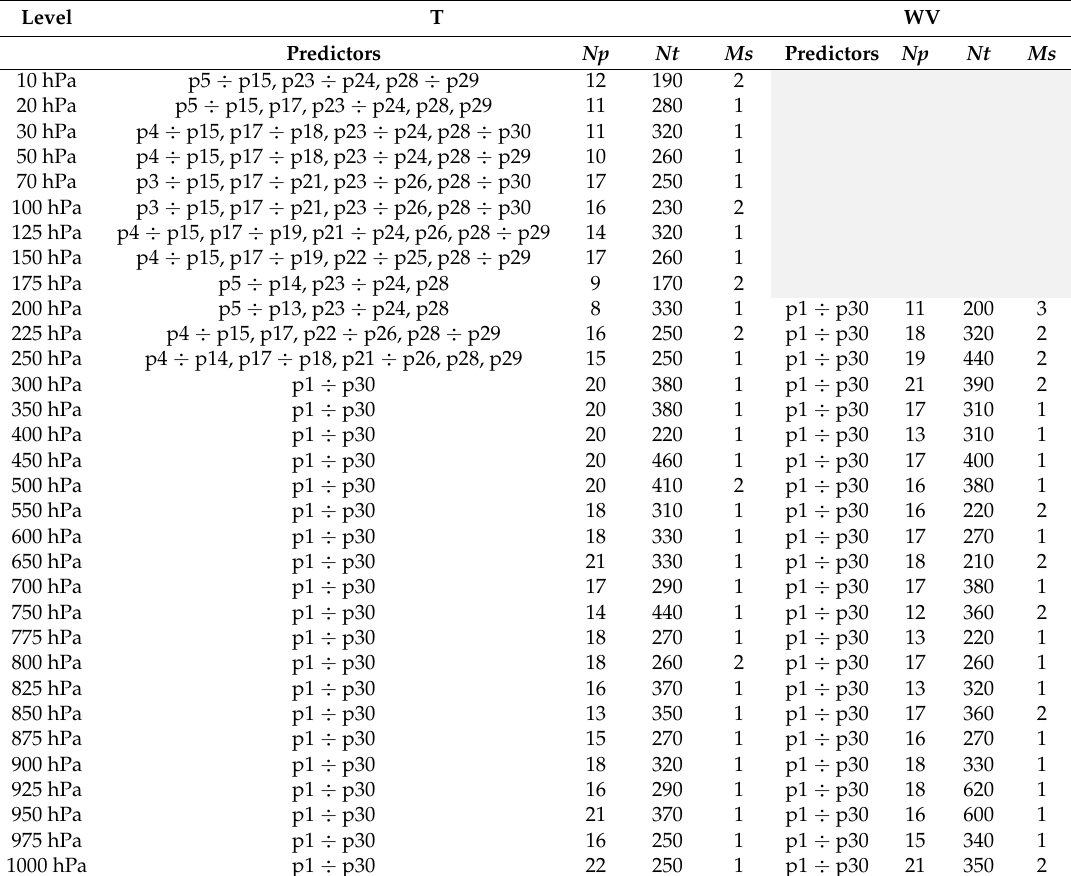
Table 4. Summary of predictors and parameters used to train the RFs. T profiles are defined within 10–1000 hPa, while WV profiles are defined within 200–1000